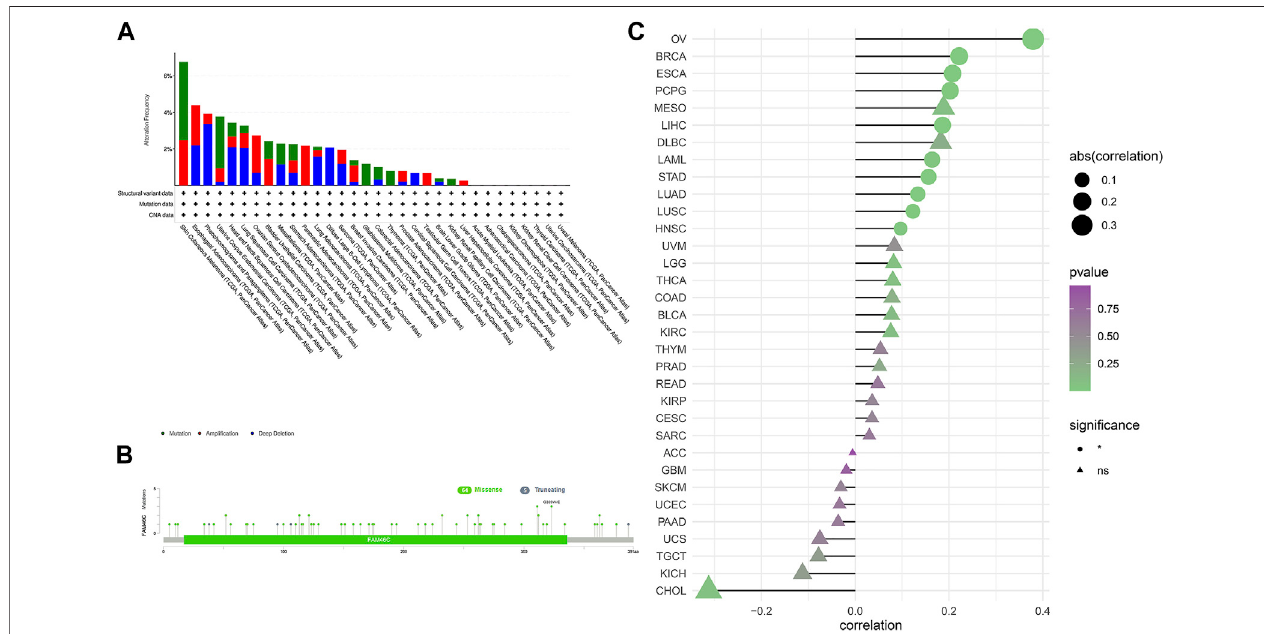
FIGURE 3 | Characterisation of FAM46C gene mutations in different TCGA tumour samples as analysed using the cBioPortal tool. (A) The type and frequency of FAM46C gene mutations in different cancers. (B) The mutation sites of FAM46C . (C) The correlation between copy number changes and FAM46C expression in each tumour sample.